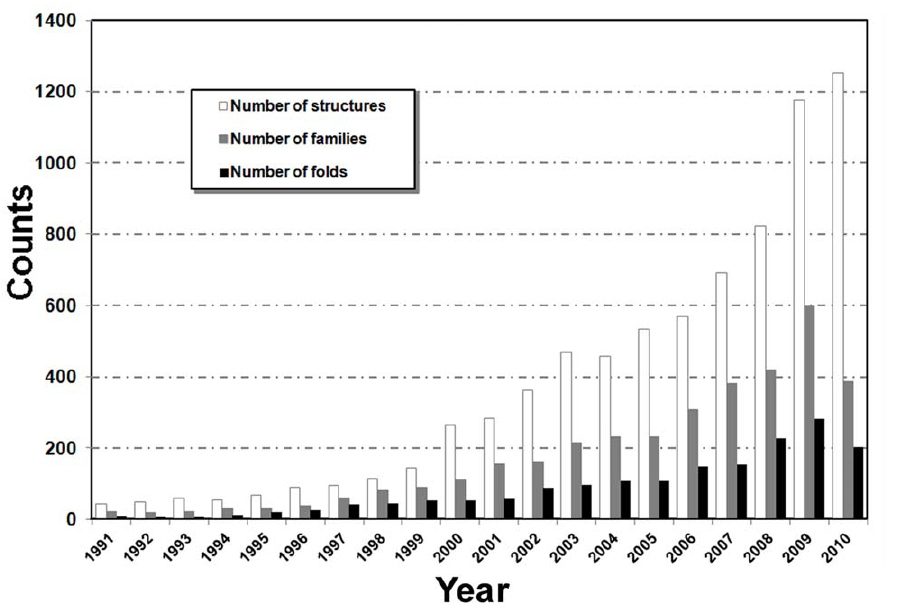
Figure 4. The number of new complex structure entries deposited per year in the PDB. Data are presented in terms of unique structures (sequence identity , 90%), families (mapped with unique Pfam families), and folds (rTM-score , 0.5).